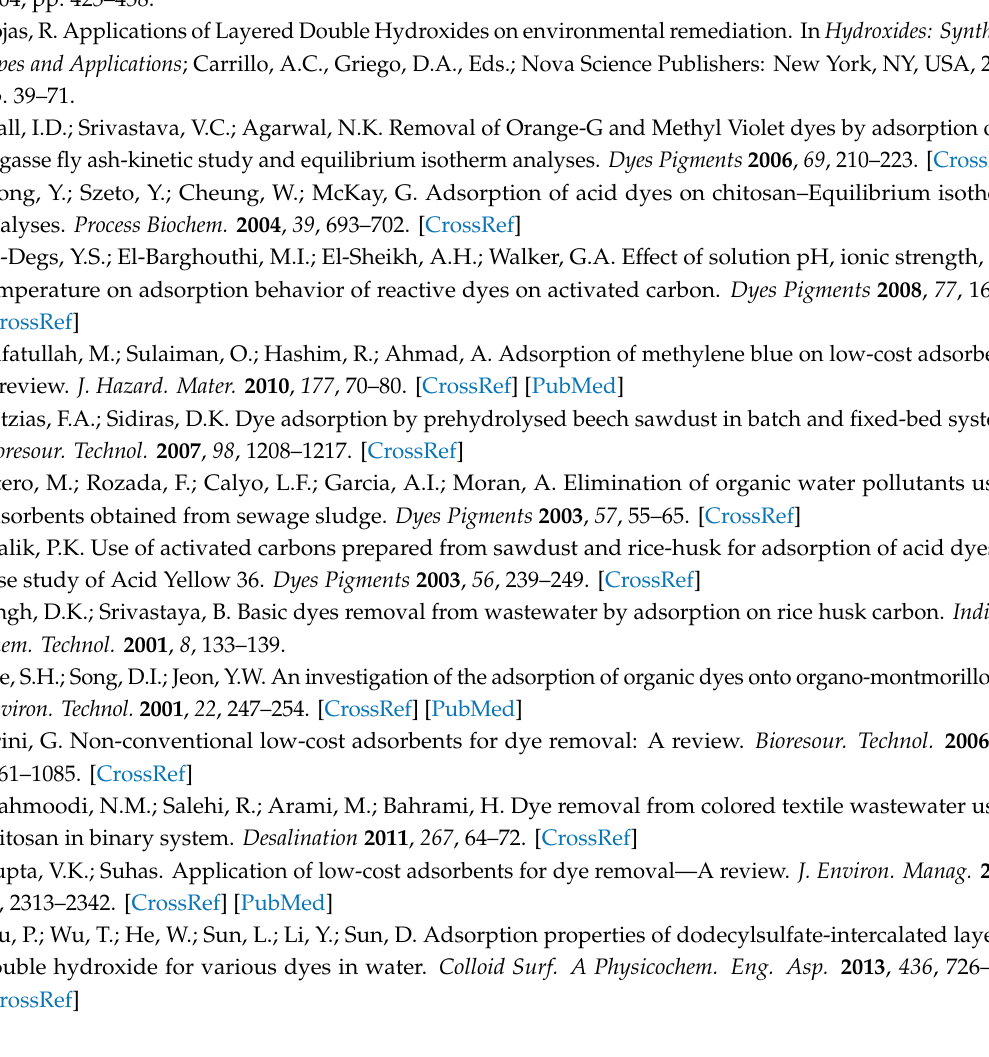
Figure S1: TG curves in N 2 atmosphere of the samples (a) Mg2AlDBS and (b) Mg3AlDBs Figure 2: Adsorption–desorption isotherms of N 2 on the LDHs samples (a) MgAlNO3 and MgAlCO3 and (b) Mg2AlDBS and Mg3AlDBS. Figure S3: Zeta potential values obtained in a KCl solution (0.01 M) at pH between 2 and 12 of the adsorbents: MgAlNO3, MgAlCO3, Mg2AlDBS and Mg3AlDBS. Figure S4: PXRD patterns of the Am adsorption products on the LDH samples: (a) MgAlNO3, (b) MgAlCO3, (c) Mg2AlDBS and (c) Mg3AlDBS. Figure S5: PXRD patterns of the DGB adsorption products on the LDH samples: (a) MgAlNO3, and (b) Mg3AlDBS. Figure S6: PXRD patterns of the BG adsorption products on the LDH samples: (a) MgAlNO3, (b) Mg2AlDBS and (c) Mg3AlDBS. Table S1: Values of the initial and final pH of the adsorption process and the percentage of Am and DGB dyes adsorbed by MgAlCO3, MgAlNO3, Mg2AlDBS and Mg3AlDBS. Co = 0.16 mmol · L − 1 except for the Am adsorption experiment by MgAlNO3 Co = 1.7 mmol · L − 1 , solid solution ratio = 1 g /